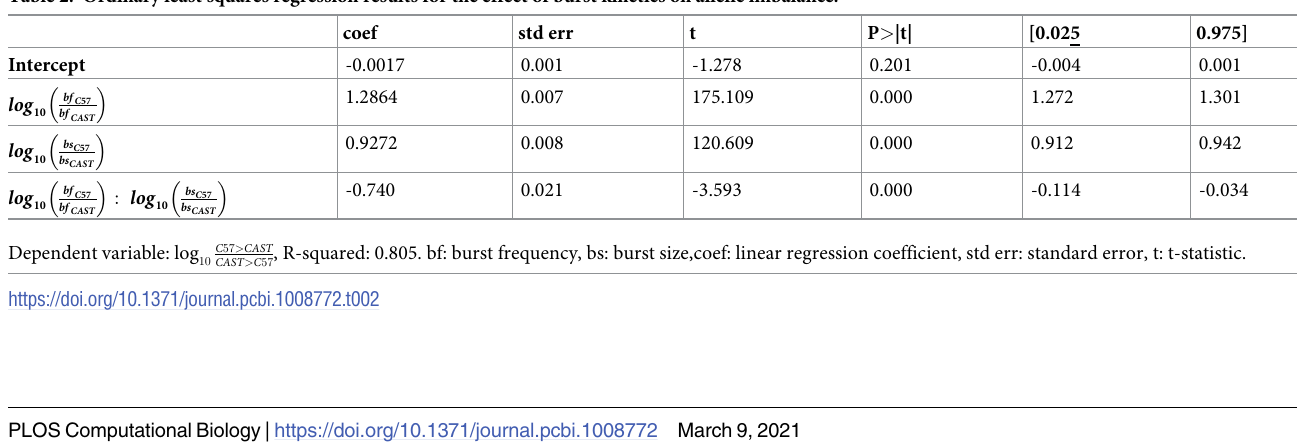
Table 2. Ordinary least squares regression results for the effect of burst kinetics on allelic imbalance. coef std err t P > |t| [0.025 0.975] Intercept -0.0017 0.001 -1.278 0.201 -0.004 0.001